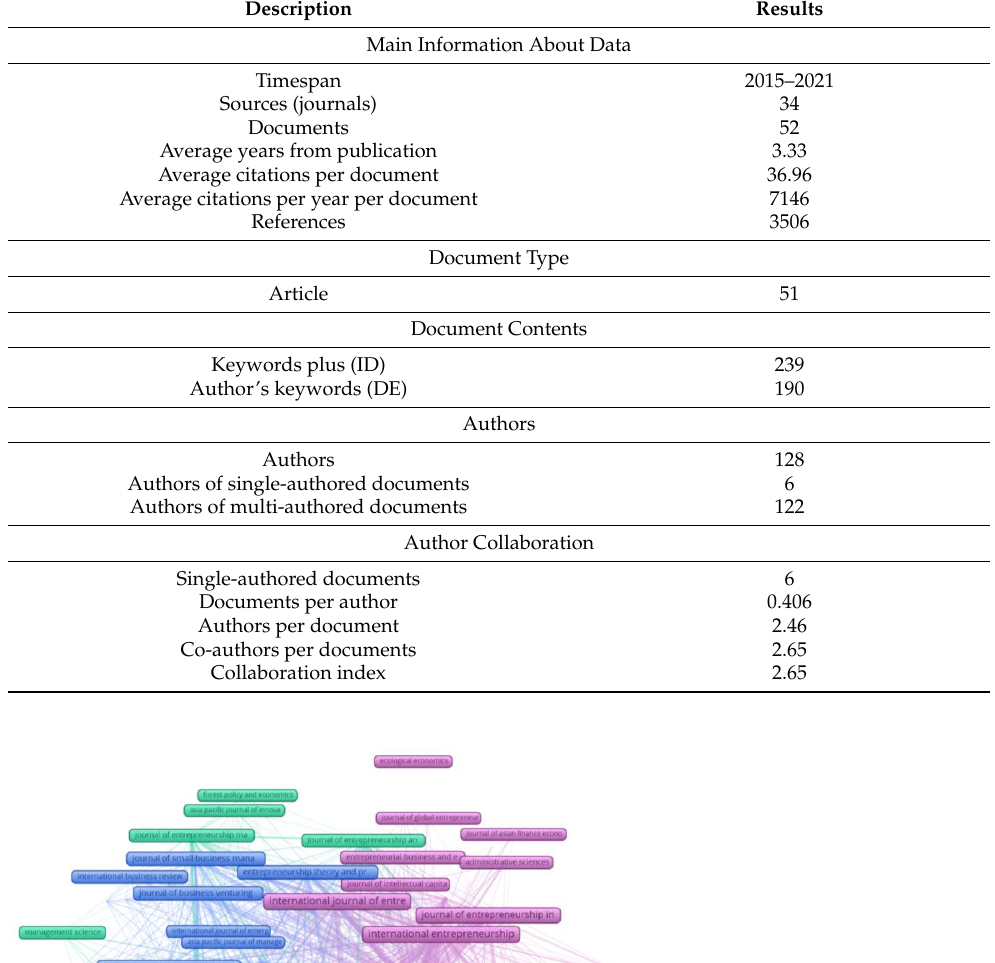
Table 2. Dataset by Bibliometrix.